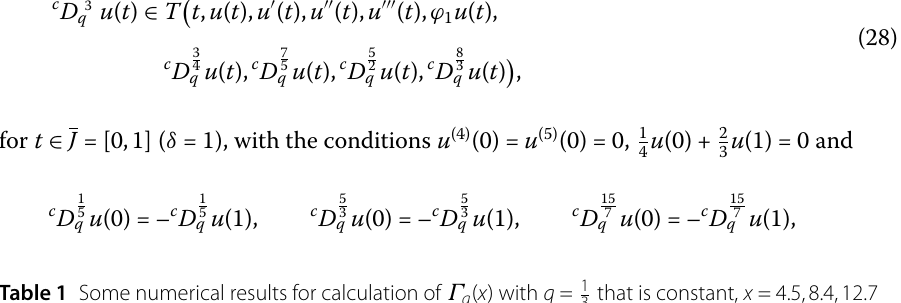
that is constant, x = 4.5,8.4,12.7 3